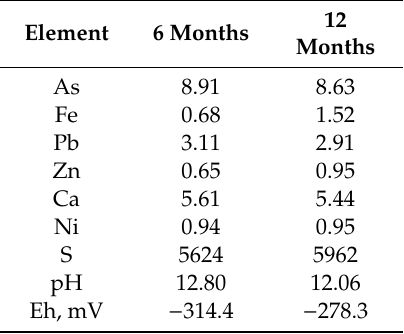
Table 7. The concentration of elements (in mg L − 1 ) in the leachates obtained according to LEC test. Element 6 Months